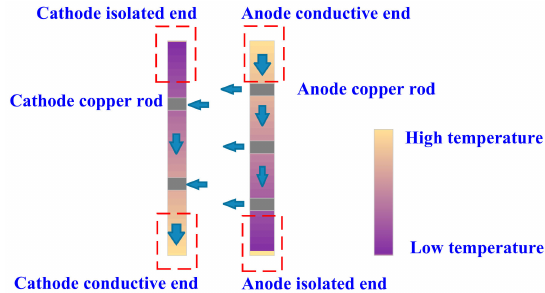
Figure 3. Temperature distribution of conductive copper